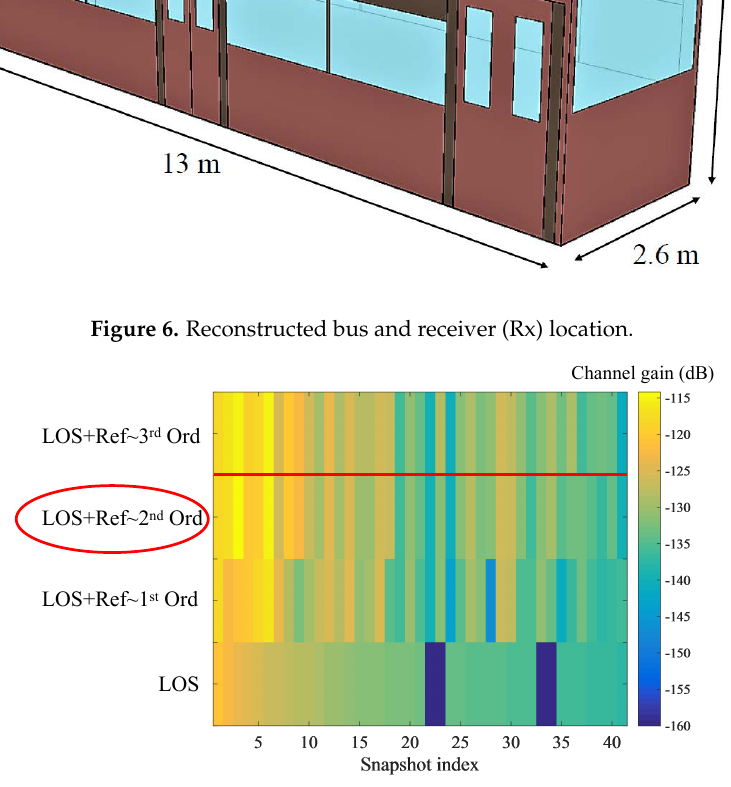
Figure 7. Channel gain of different combinations of